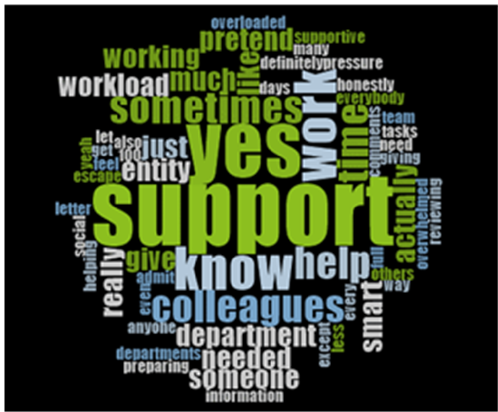
Figure 2. Word cloud depicting OCB among the Cluster 2 participants.